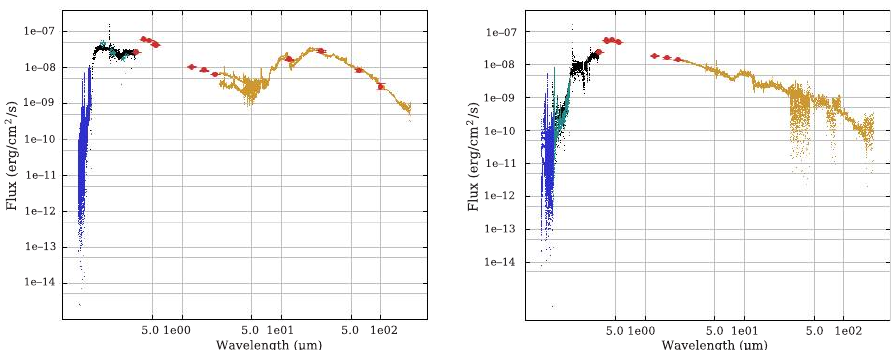
Fig. 1. Examples of Herbig Ae/Be star SEDs. A Group I source is shown on the left (HD 100546) and a Group II source, on the right (HD 104237). The SEDs have been built up, using VOSpec, from spectra within the VO: from FUSE (blue), IUE (black), HST (cyan) and ISO (orange), and from photometric data using VOSED: from Str(cid:127)omgren, Tycho-2, 2MASS PSC, and IRAS PSC catalogues (red). Neither SEDs are corrected for